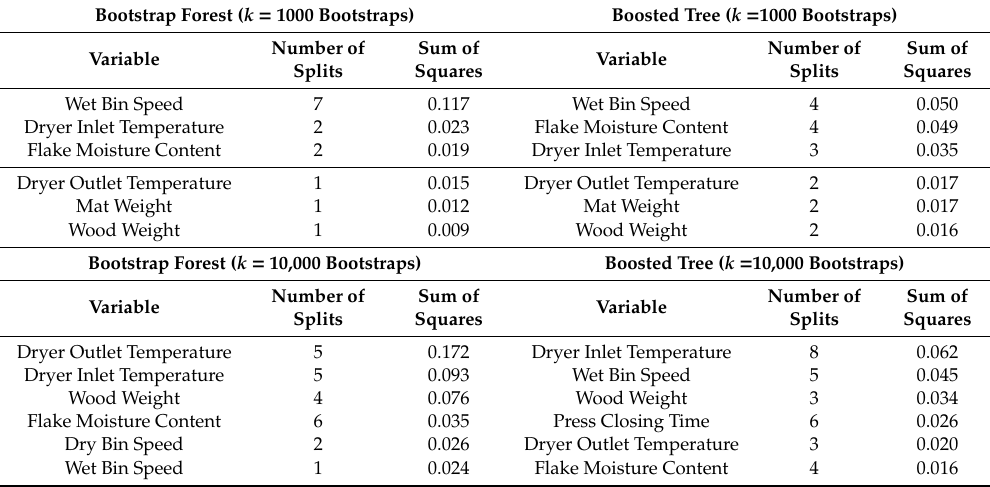
Table 3. Common predictors variables for both bootstrap forest and boosted tree models for OSB after k = 1000 bootstraps, ranked by highest sums of